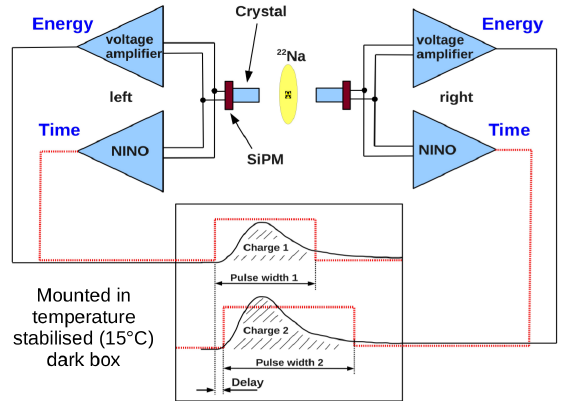
Figure 20. Schematic representation of the coincidence time resolution (CTR) bench [72]. SiPM, silicon photo-multiplier.